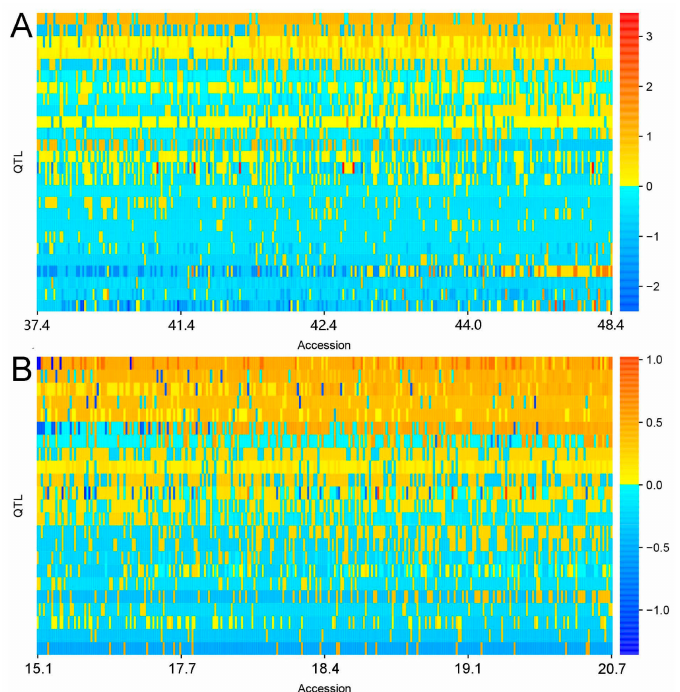
Figure 4. Graphical representation of QTL–allele matrices of seed protein ( A ) and oil ( B ) content detected in the soybean association panel. The horizontal axis indicates accessions arranged in ascending order of seed protein or oil content (%), while the vertical axis indicates QTLs arranged in ascending order of their positive allele frequency. Every row indicates the allele distribution among accessions at a QTL, while every column indicates the allele constitution of an accession over all QTLs. Allele e ff ects are expressed in color cells where warm colors indicate positive e ff ects, cool colors indicate negative e ff ects, and the color gradient indicates e ff ect